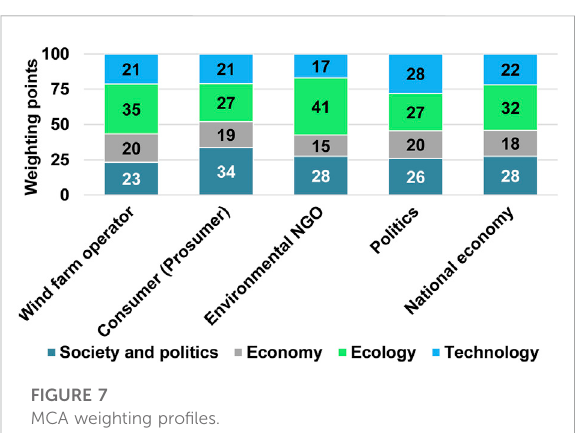
FIGURE 8 Aggregated MCA result from a national economy